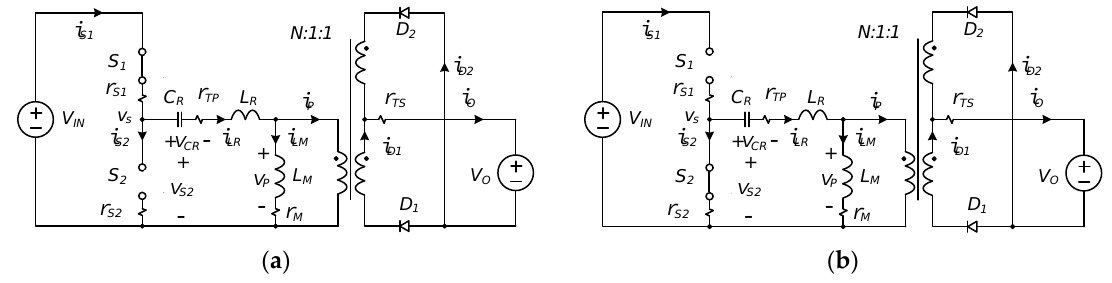
Figure 3. Equivalent circuit of LLC resonant converter with internal resistance.